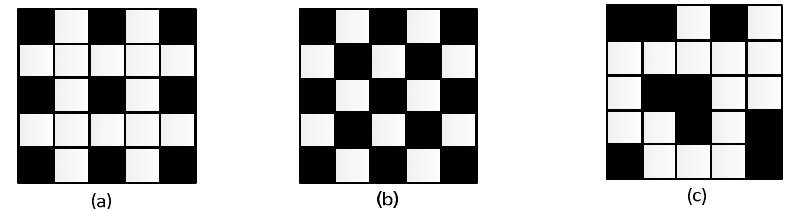
Figure 11. Typical block loss mode. ( a ) Isolate block loss. ( b ) Consecutive block loss. ( c ) Random block loss.